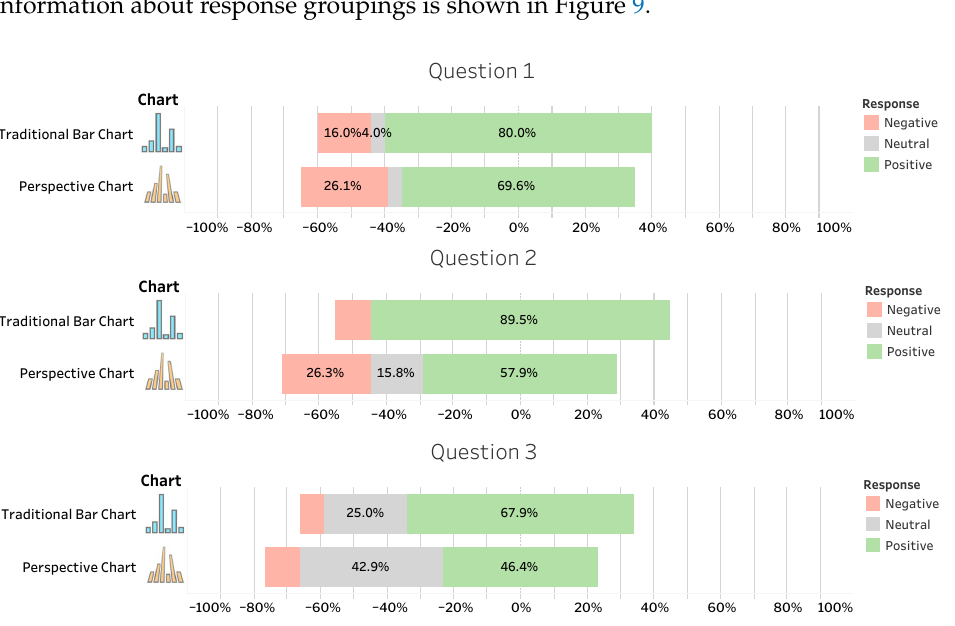
Figure 9. Qualitative evaluation results. Responses that indicated they did not use the specified feature of the system are